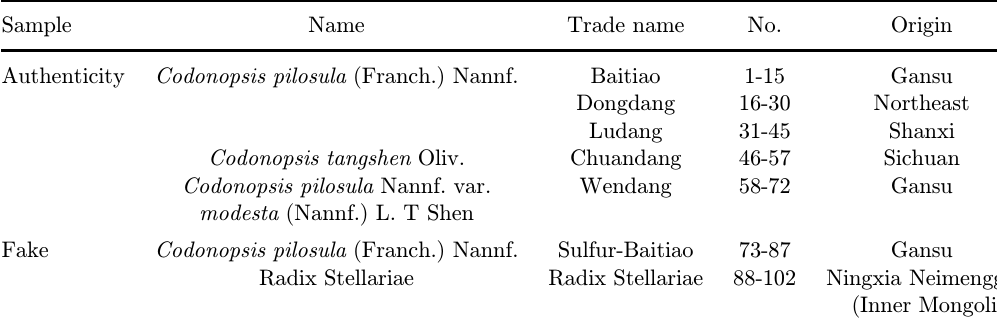
Table 1. Information on